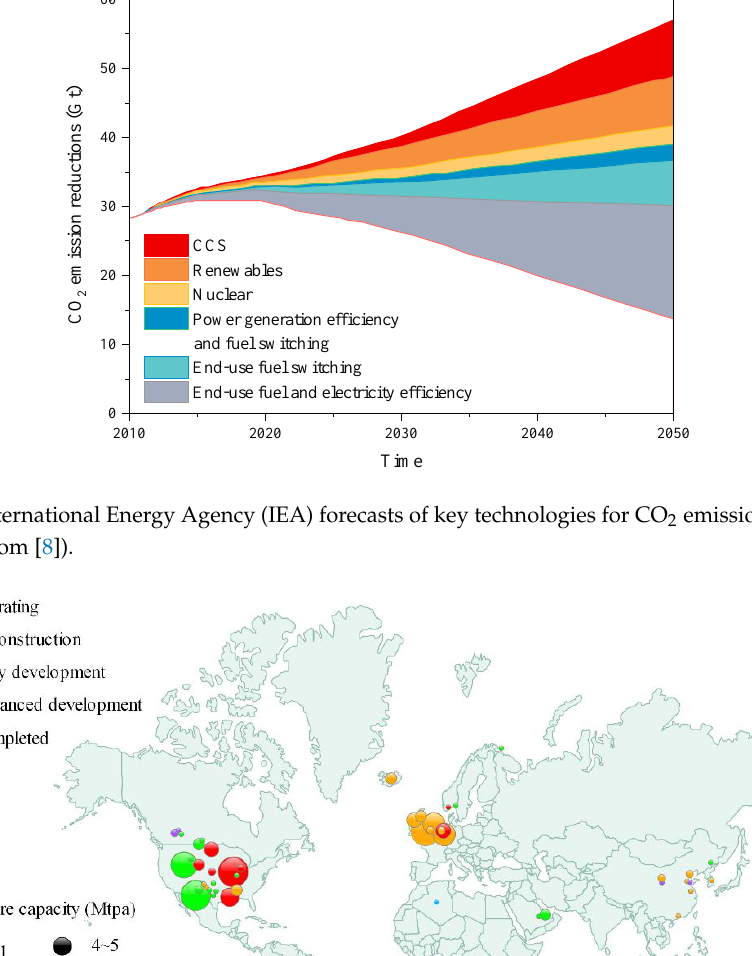
Table 1. Summary of review literature on CCS technology.